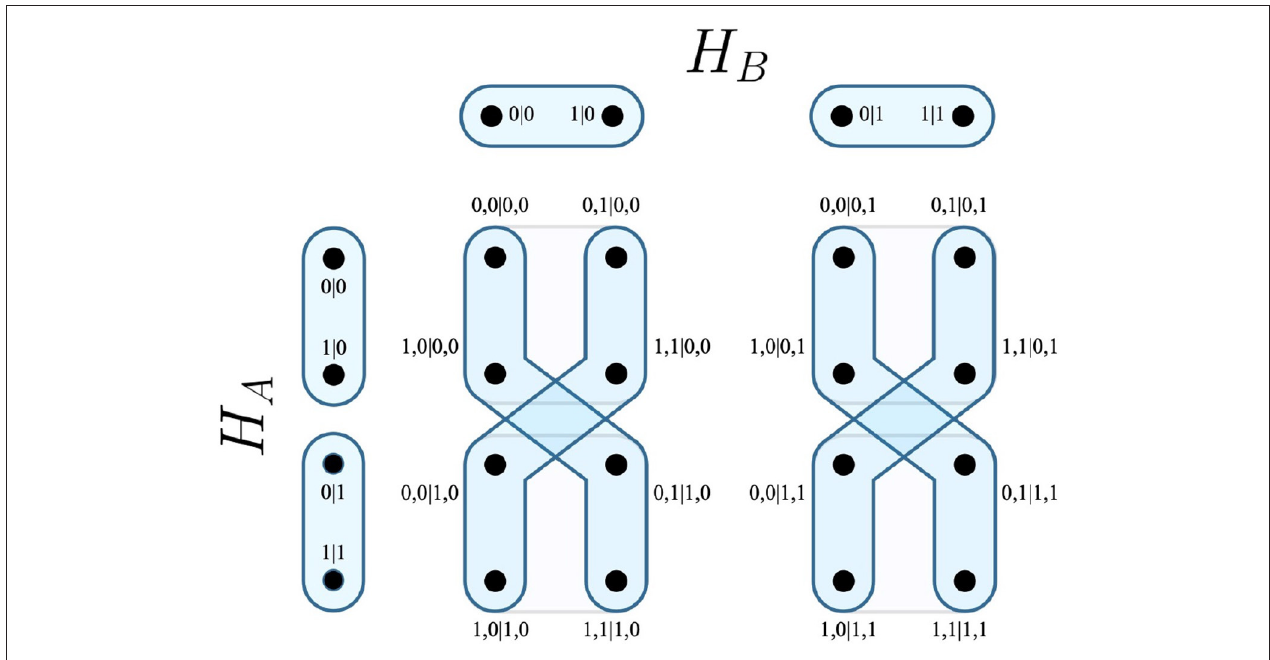
FIGURE 2 | Measurement protocol E H